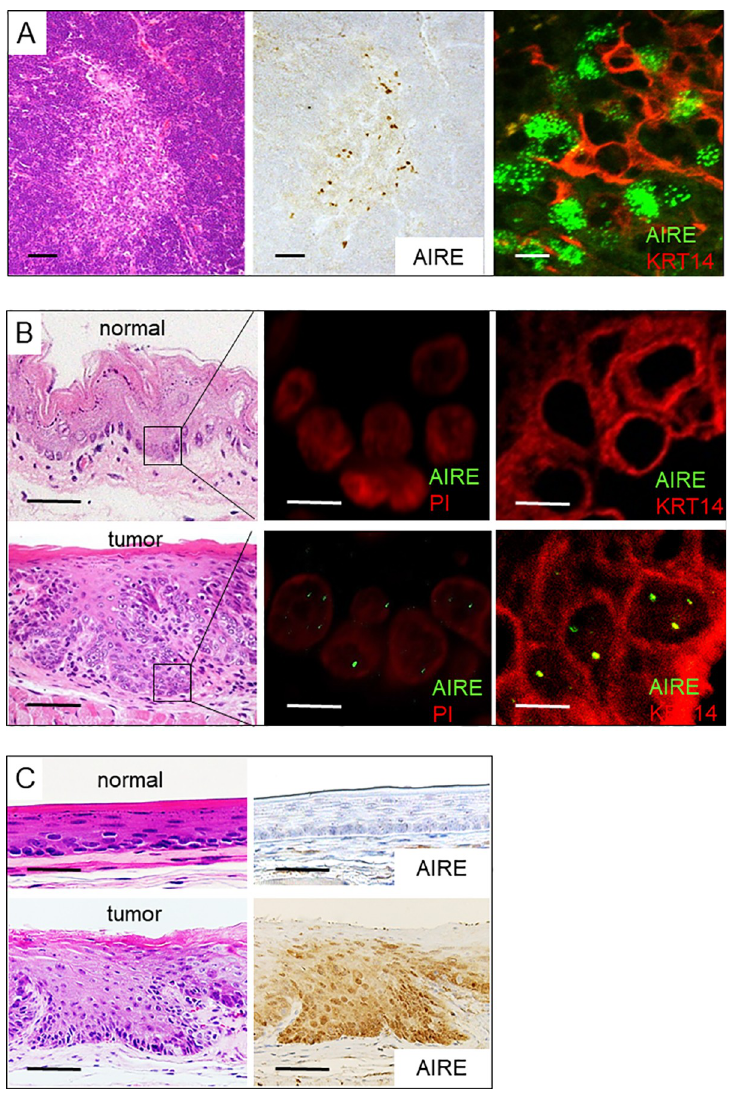
Fig 1. AIRE expression in esophageal tumors in mice. A) AIRE expression in the thymic medullary epithelium. Hematoxylin and eosin staining (left panel), immunohistochemical staining using 3,3’-DAB (middle panel), and immunofluorescence double staining with KRT14 (right panel). Scale bar: 50 μ m(left and middle panels), 10 μ m(right panel). B) AIRE expression in neoplastic cells of the esophagus. Immunofluorescence staining (middle panel) and immunofluorescence double staining with KRT14 (right panel). PI: propidium iodide. Scale bar: 50 μ m(left), 5 μ m (middle and right panels). C) Expression of AIRE in neoplastic cells of the esophagus as revealed by immunohistochemical staining using DAB. Scale bar: 50 μ m.A representative negative-control image using nonspecific rabbit IgG instead of anti-AIRE antibody is shown in S1 Fig. detected by RT-PCR in all the SCC cell lines examined as well as in normal keratinocytes. The level of expression was quantitated using real-time PCR analysis, which revealed that AIRE was upregulated in the oral cancer cell lines when compared with the normal keratinocytes (Fig 2A). Northern blot analysis failed to detect AIRE in any cells, suggesting a low amount of transcripts. Western blot analysis using an anti-AIRE antibody revealed that all the SCC cell lines exam- ined expressed AIRE at substantially higher levels than did normal keratinocytes (Fig 2B). We